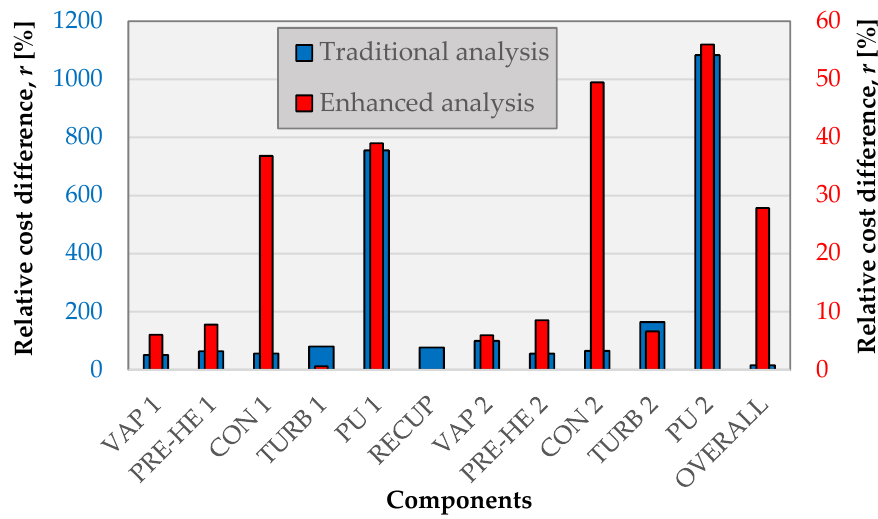
Figure 2. Change in total operating cost for the components for both analyses.